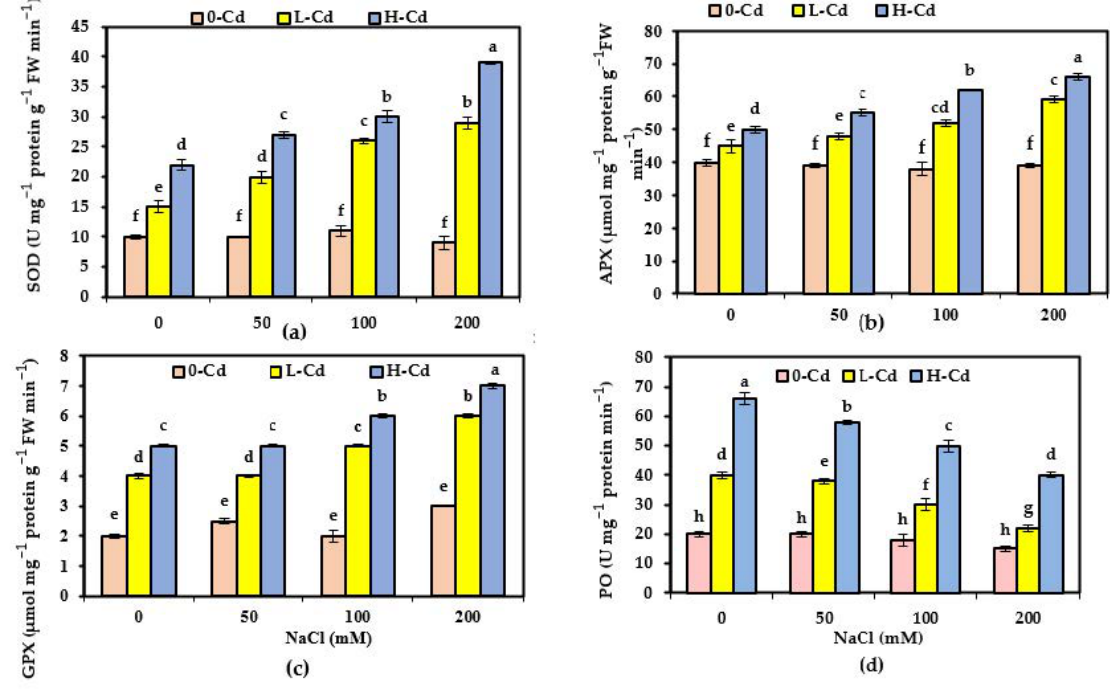
Figure 3. Activities of superoxide dismutase (SOD; U mg − 1 protein g − 1 FW min − 1 ), glutathione peroxidase (GPX; μmol mg − 1 protein g − 1 FW min − 1 ), ascorbate peroxidase (APX; μmol mg − 1 protein g − 1 FW min − 1 ), and peroxidase (PO; U mg − 1 protein min − 1 ) ( a , b , c , d , respectively) in leaves of Salicornia fruticosa exposed to nutrient solution containing 0, 25, and 50 μg L − 1 Cd (0-Cd, L-Cd, and H-Cd, respectively) without or with 50, 100, and 200 mM NaCl. Each value is the average of four replicates ± SE. Values bearing different letters are significantly different at p < 0.05 based on Tukey’s